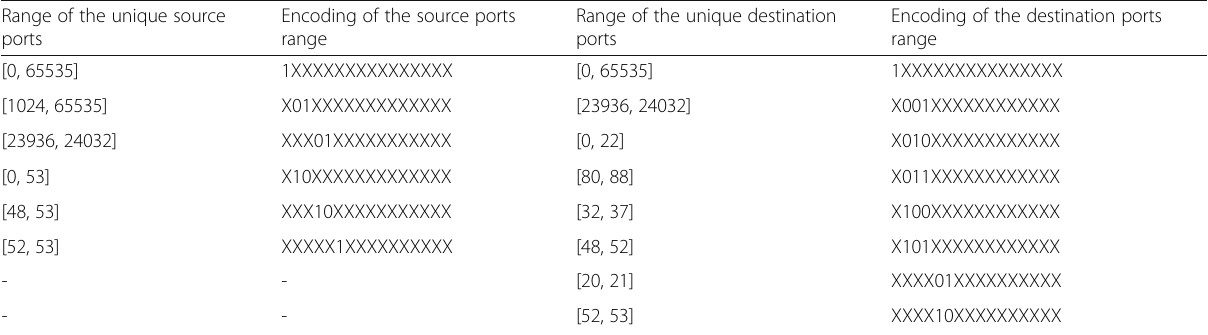
Table 3 Encoding the range of unique source and destination ports of the rule set of Table 1 Range of the unique source Encoding of the source ports ports